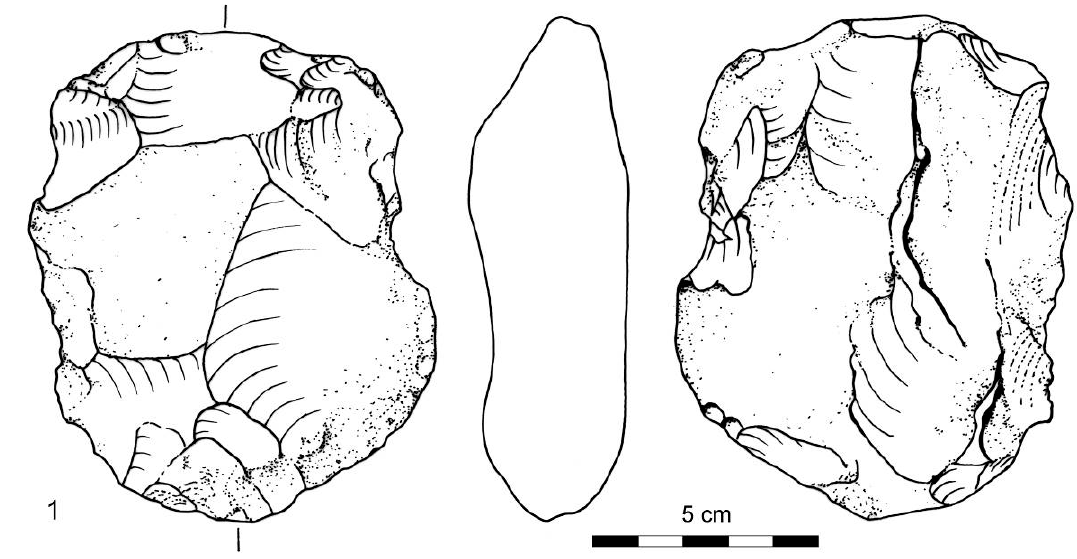
Figure 13. An example of a stone weight flaked on both sides (no. 1 in Figure